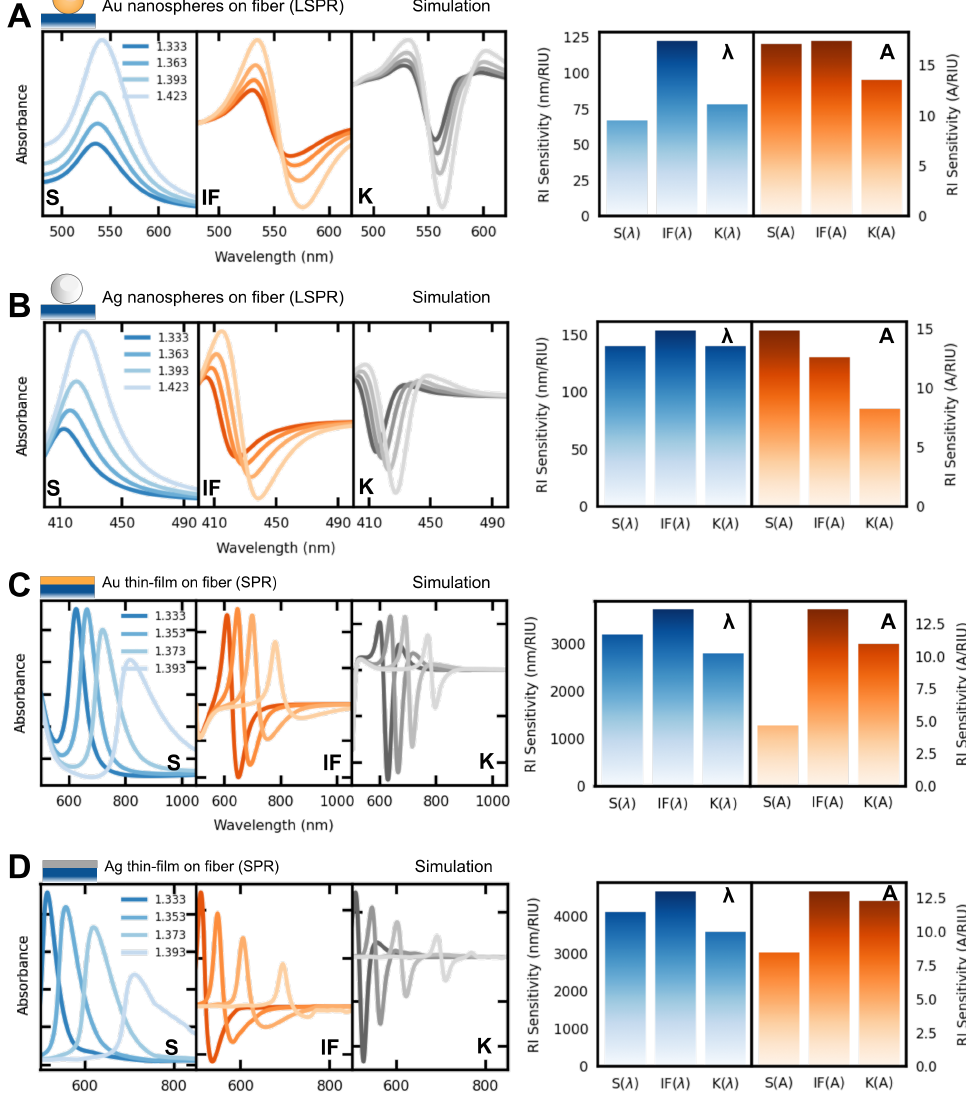
Figure 3. Simulated refractometric responses of different plasmonic optical fibers. Left panel: extinction spectra (S) as a function of the surrounding refractive index and the first two derivatives (IF) and (K), respectively. Right panel: RI sensitivity calculated from S, IF, and K; ( A ) gold NS, ( B ) silver NS, ( C ) gold thin film, and ( D ) silver thin film, on a multi-mode optical fiber (as schematically represented above the